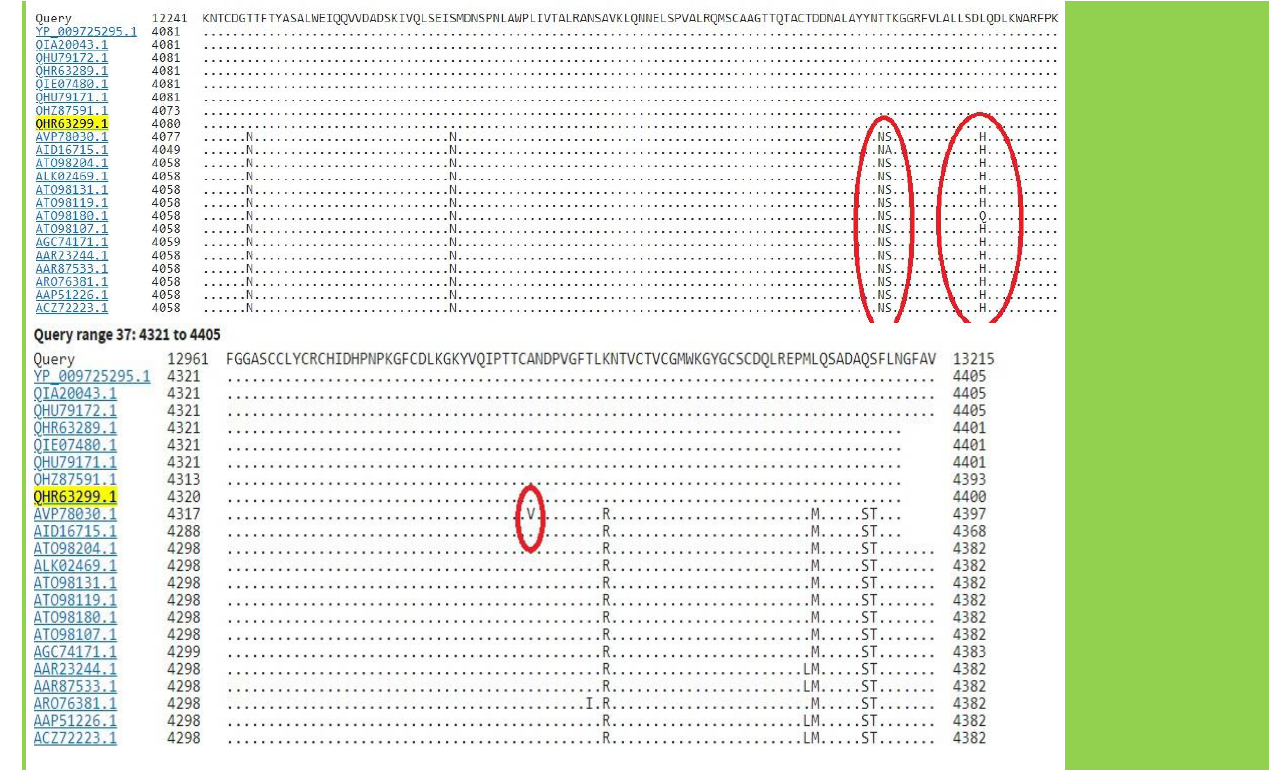
Figure 2. Sequence amino acid analysis of Coronavirus isolate by NCBI.